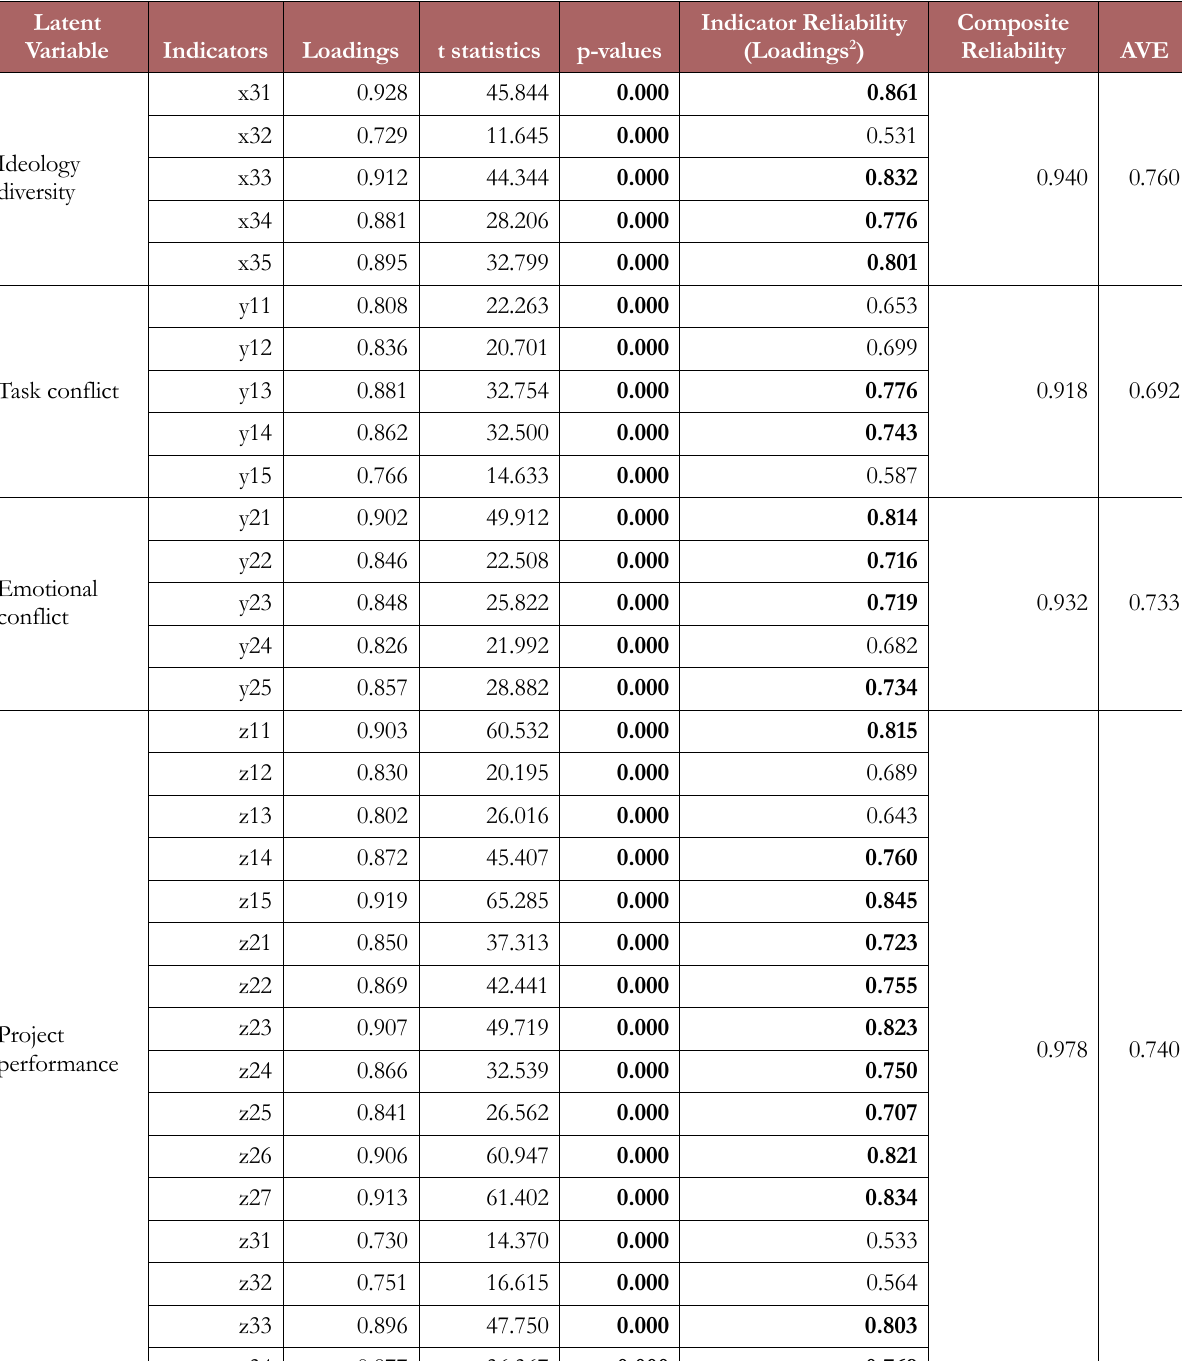
Table 6. Summary of Results for Outer Models (Reflective